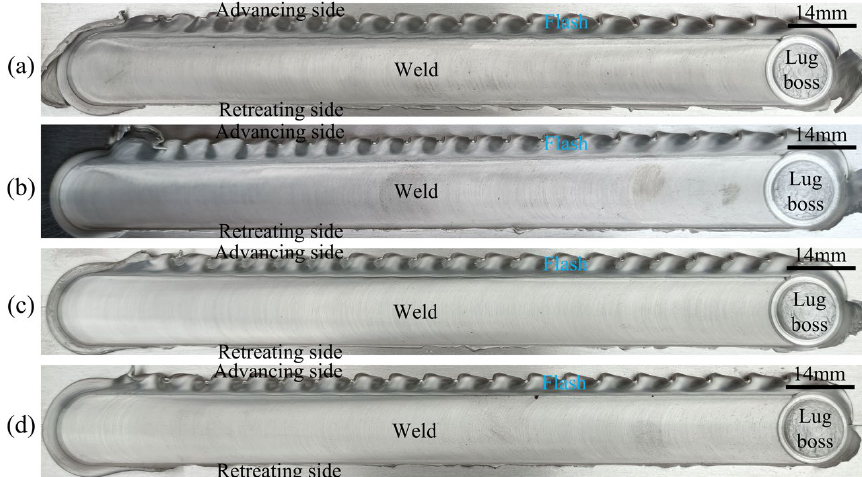
Figure 6. Effect of the welding speed on the weld morphology: ( a ) v = 30 mm/min; ( b ) v = 50 mm/min; ( c ) v = 80 mm/min; ( d ) v = 100 mm/min; ( ω = 900 rpm, d = 12 mm).